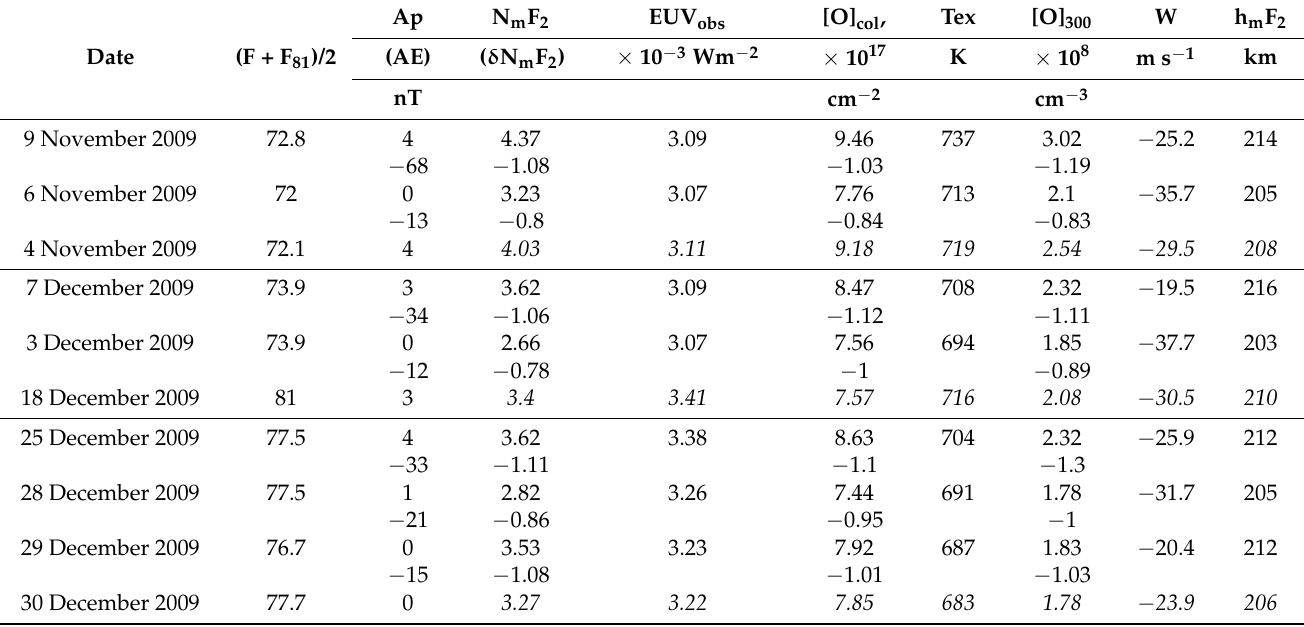
Table 1. Analyzed Q-disturbances of the ‘meteorological’ origin at Juliusruh. The table shows the observed half-sum of the daily and 81-day average F 10.7 , the daily Ap and AE indices, the observed values averaged over three (11–13) LT N m F 2 (in 10 5 cm − 3 ) along with δ N m F 2 = N m F 2 Qday /N m F 2 med (in brackets), the observed daily EUV, the calculated [O] column abundance, the retrieved exospheric Table 300 km along with δ [O] = [O] Qday /[O] med day (in brackets), the vertical plasma drift W and h m F 2 . Dates and data given in italic, which correspond to dates with N m F 2 close to the monthly median N m F 2 .